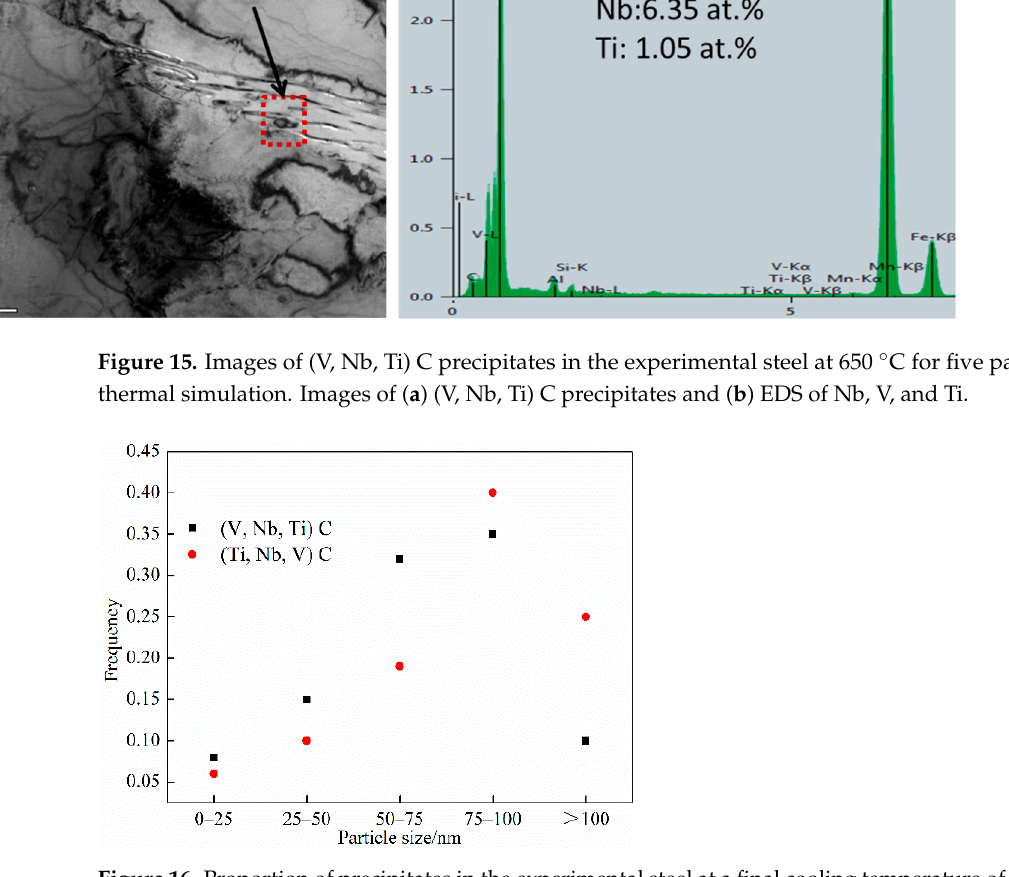
Figure 16. Proportion of precipitates in the experimental steel at a final cooling temperature of 650 °C.